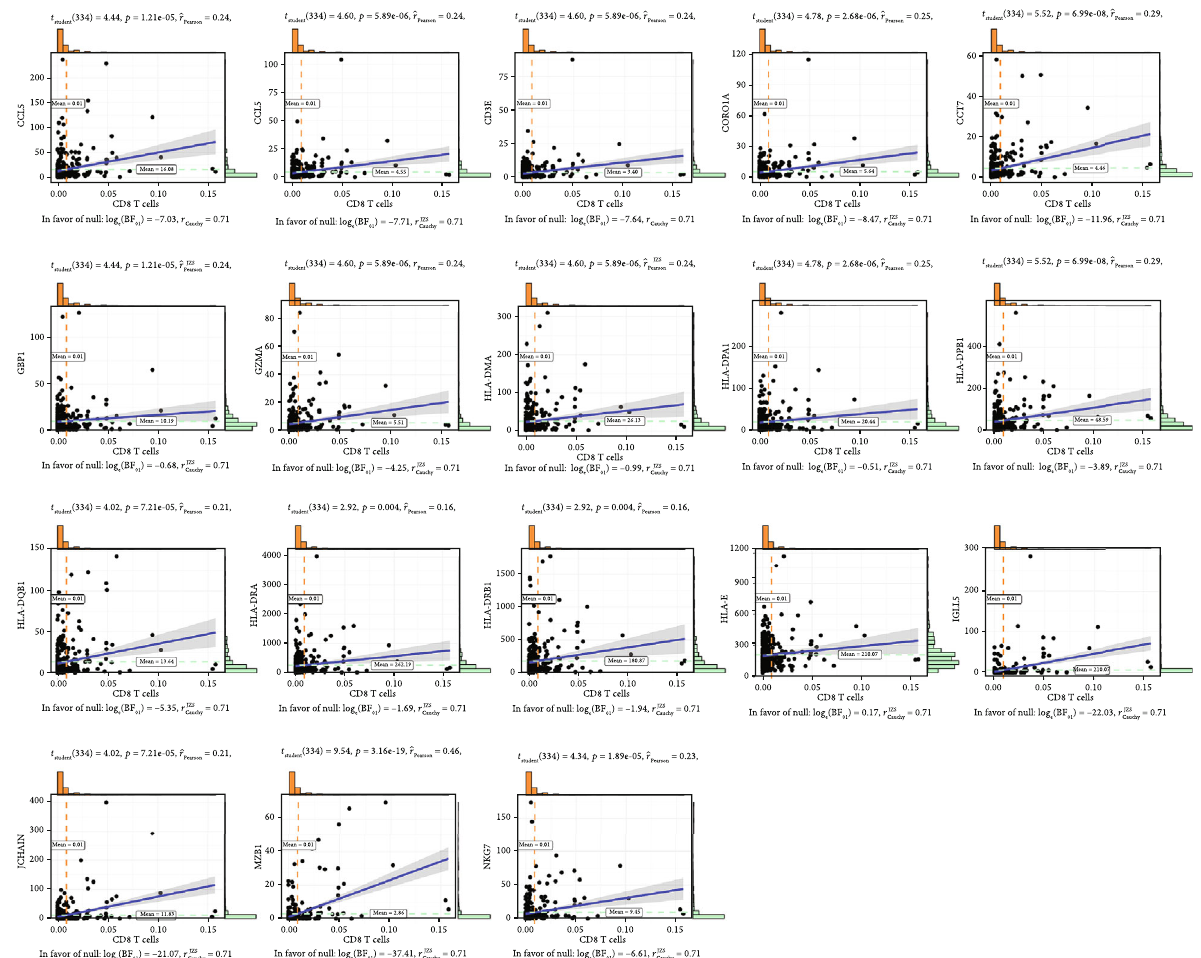
Figure 5: The Pearson correlation test among genes in magenta and grey60 modules with CD8+ T cell proportions.